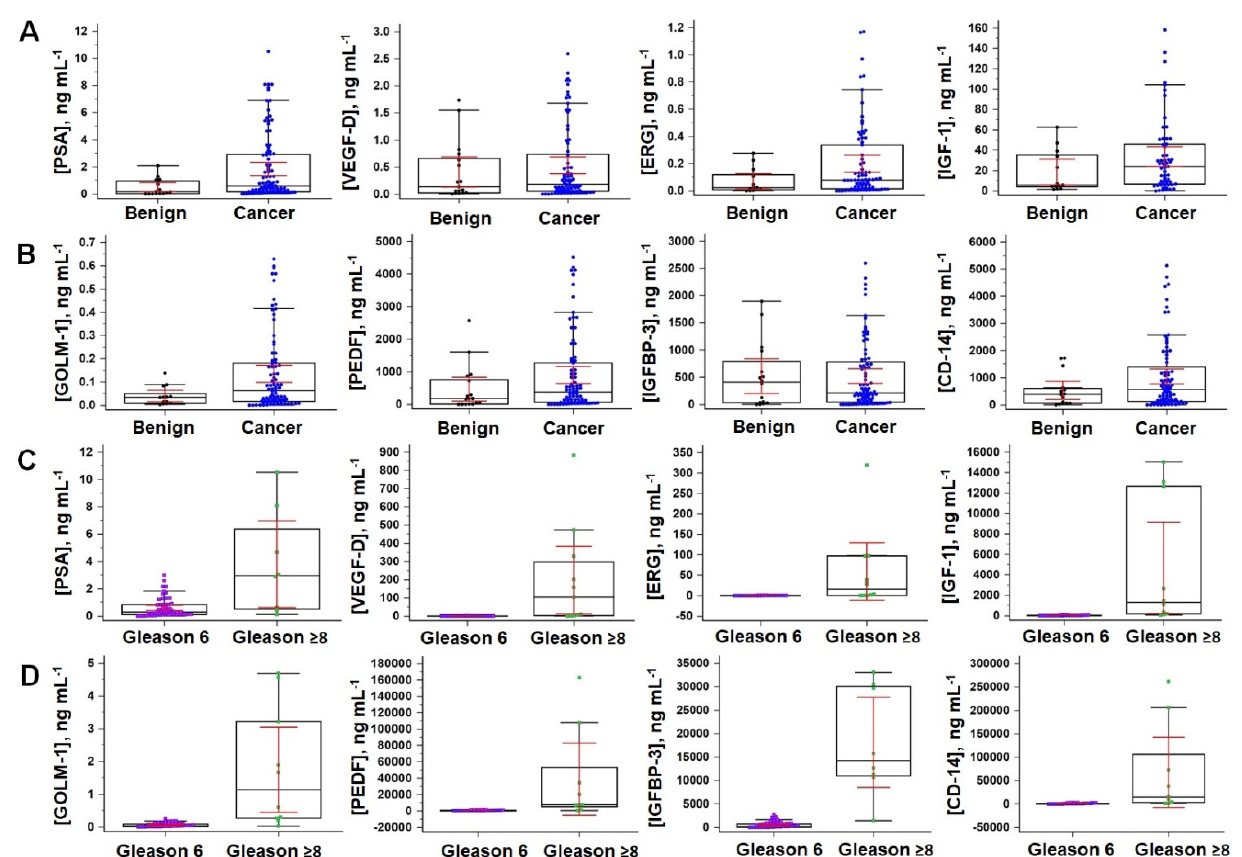
Figure 5. Box plots for patient samples. Protein biomarker levels in male patient serum (excluding outliers): ( A , B ) benign vs. cancer (high end outliers removed). ( C , D ) Indolent vs. aggressive (indolent—Gleason score of 6, aggressive—Gleason score >8). Error bars at 95% confidence. Reproduced from [34], copyright America Chemical society, 2021.